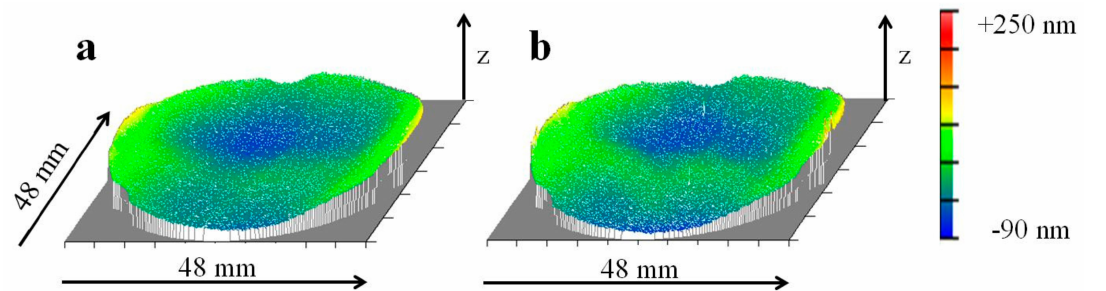
Figure 8. Residual change in shape deviation of the optical surface of a mirror made of Al-42Si, after second single-point diamond turning exhibiting 31 nm RMS ( a ); after 30 environmental thermal cycles exhibiting 34 nm RMS ( b ).